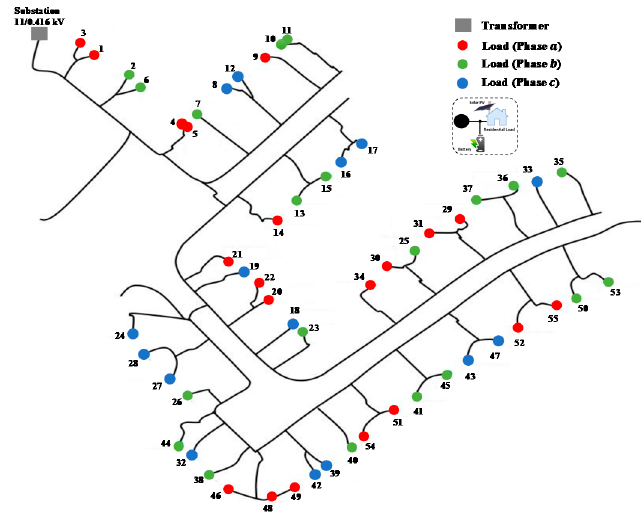
Figure 3. The modified IEEE low voltage test feeder.